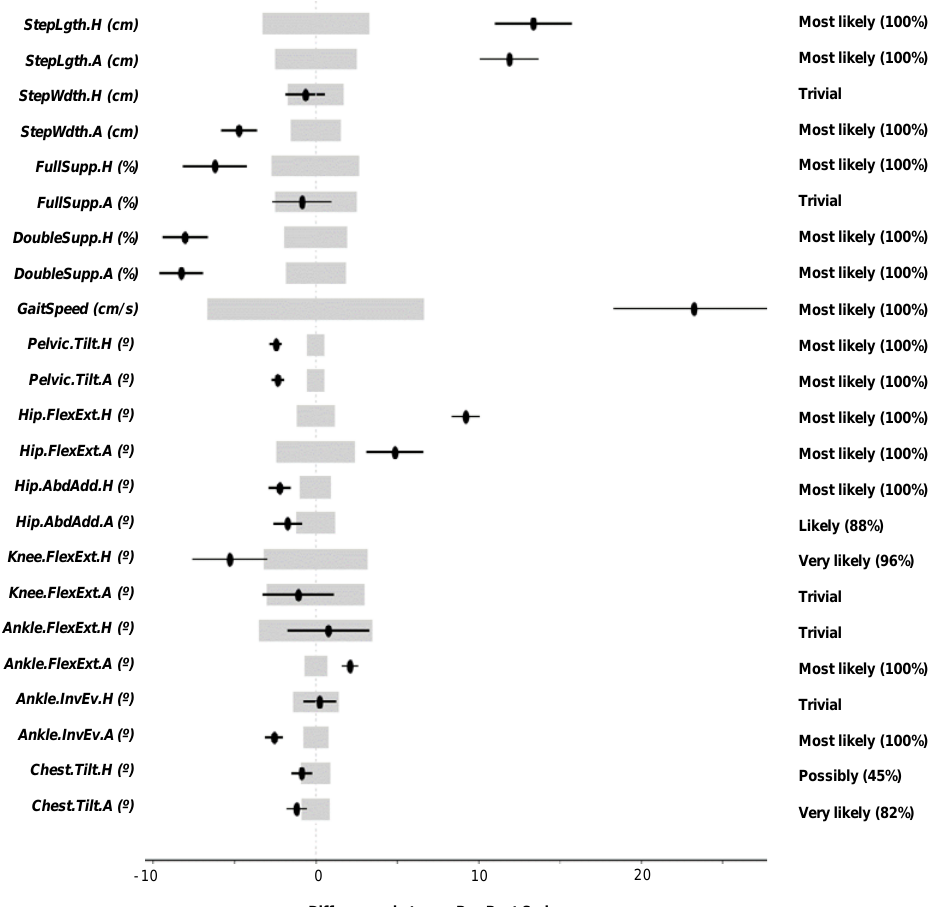
Figure 3. Patient-level analysis and confidence interval representation for Patient S014. Wide light grey bars: MBD threshold. Thin black bars: Confidence interval of the difference ( CIdif ).